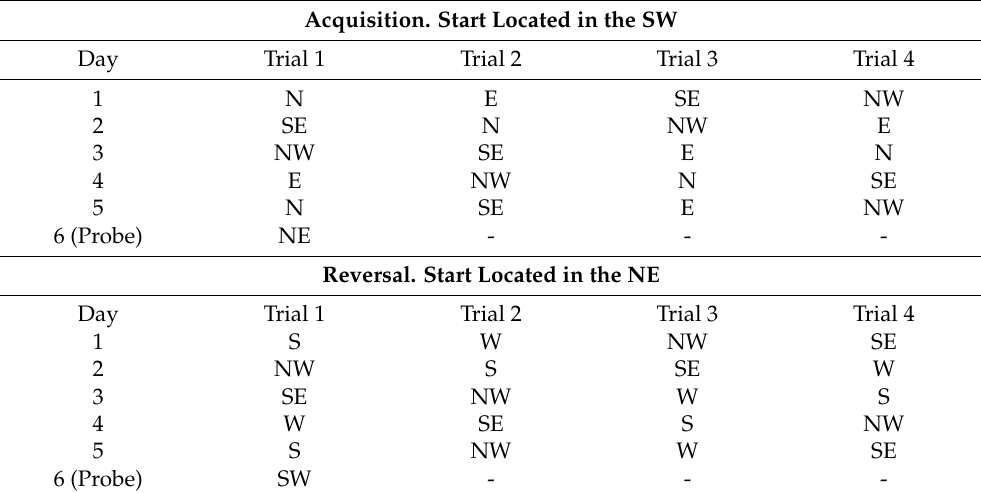
Table 2. Scheme of Morris water maze experiment for the study of reference memory with an indication of starting point and goal platform.